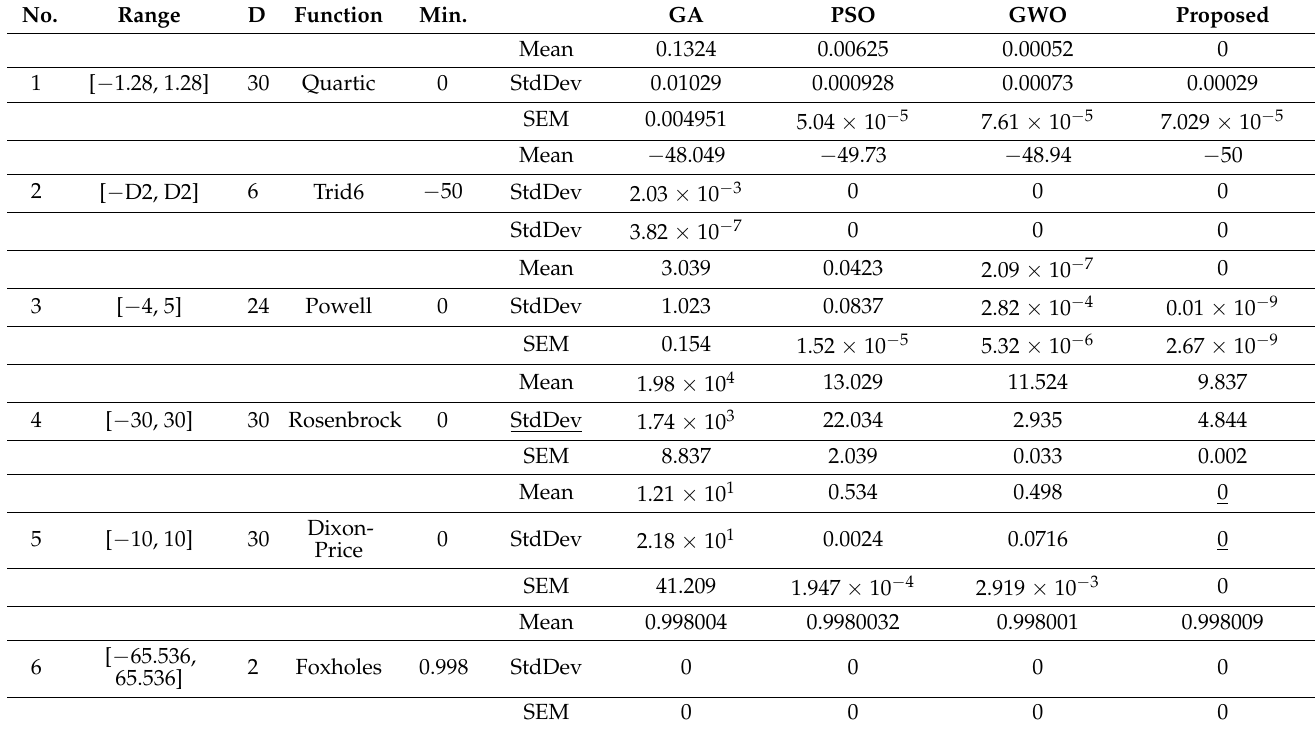
Table 2. Statistical results obtained by GA, PSO, GWO and proposed through 30 independent runs on mentioned benchmark functions in Table 1.